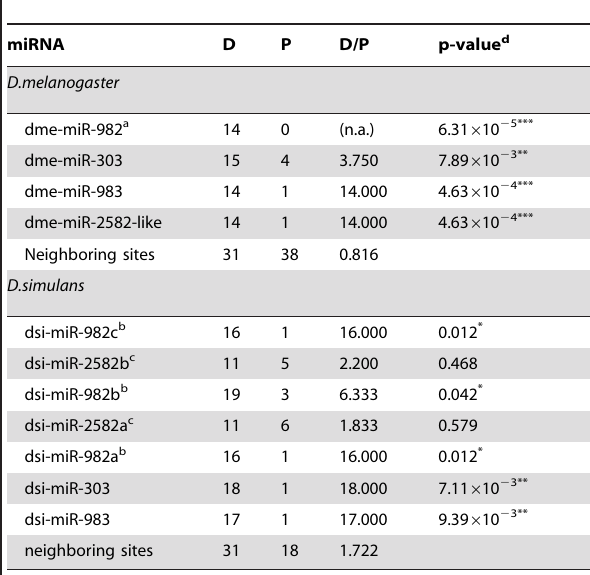
Table 2. The McDonald-Kreitman test on individual miRNAs of the miR-982s